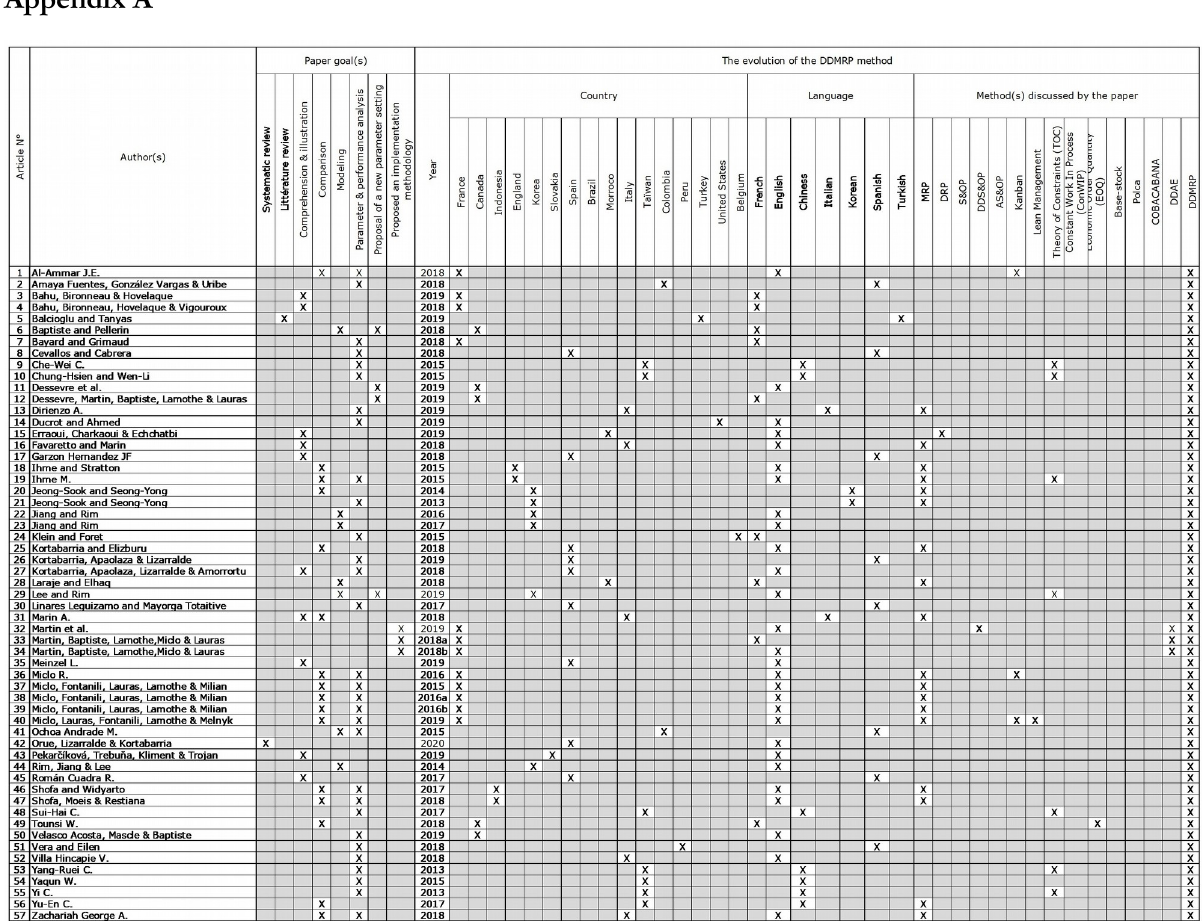
Table 4. The evolution of the DDMRP